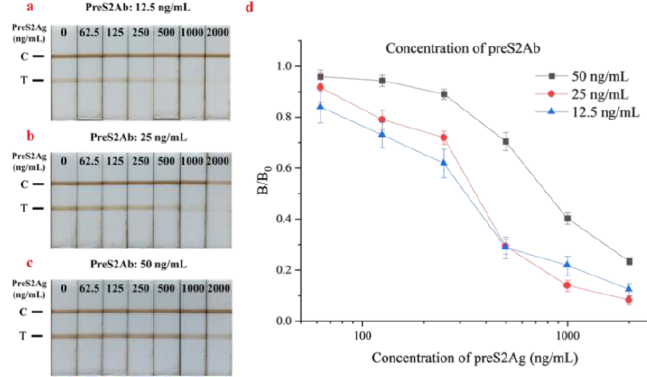
Figure 5. Qualitative results ( a – c ) and quantitative results ( d ) for different concentrations of preS2Ab antibody in sample pre-incubation. The error bars represent the standard deviation of three repeats (n = 3).